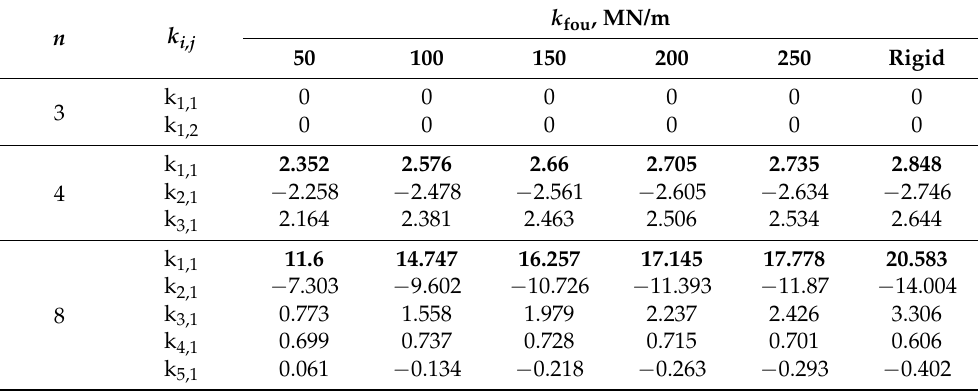
Table A5. Values k i,j of stiffness matrix k expressed in MN/m, for n = 3, n = 4 and n = 8 and k fou =